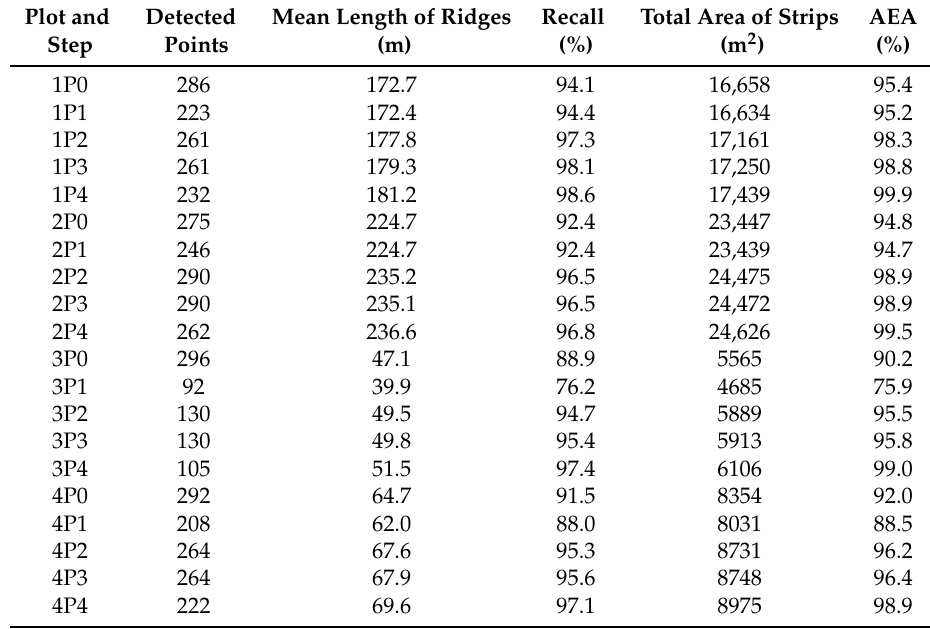
Table 6. Accuracy assessment of point reduction and improvement.